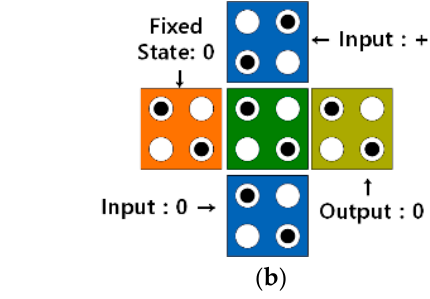
Figure 2. 3-input majority gate: ( a ) OR gate; ( b ) AND gate.